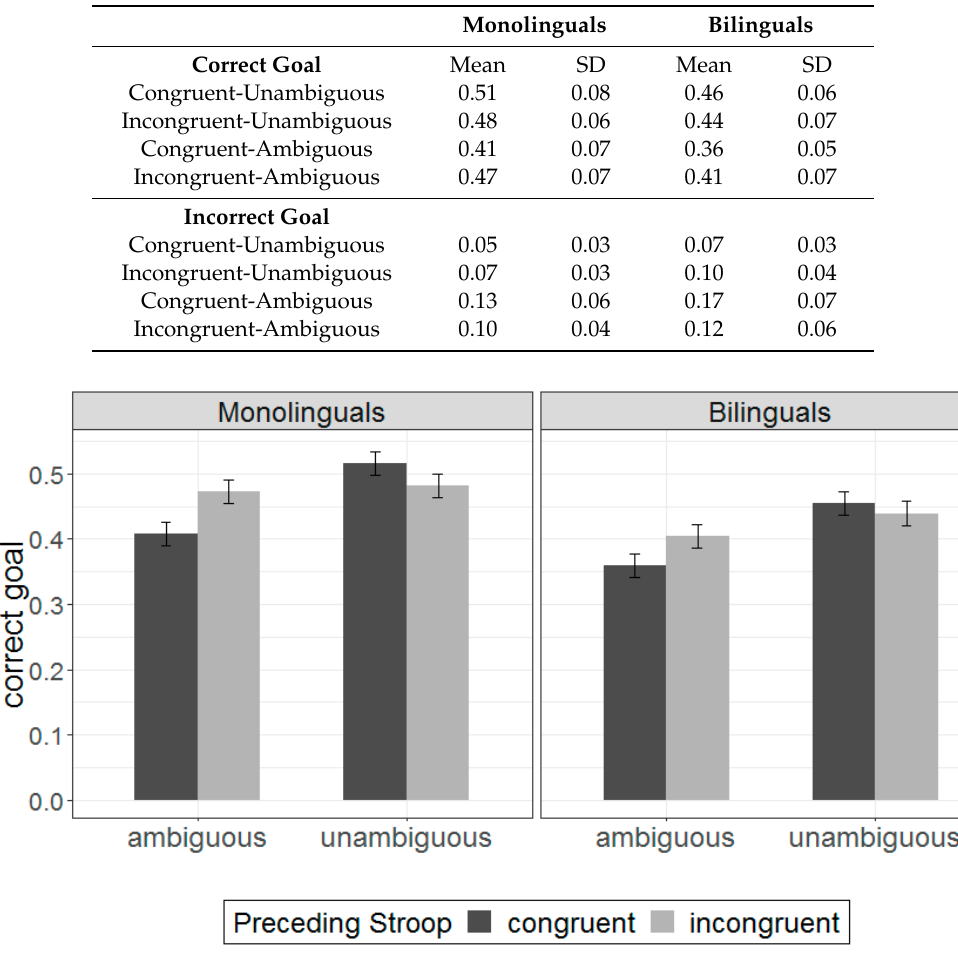
Figure 2. Estimated e ff ects for correct-goal fixations for ambiguous sentences as a function of prior Stroop trial type. Higher values on the y-axis indicate more looks to the correct goal object (e.g., a box. Fixations were averaged from the onset of the second noun phrase (e.g., napkin) through the action period. Error bars indicate standard error of the mean.